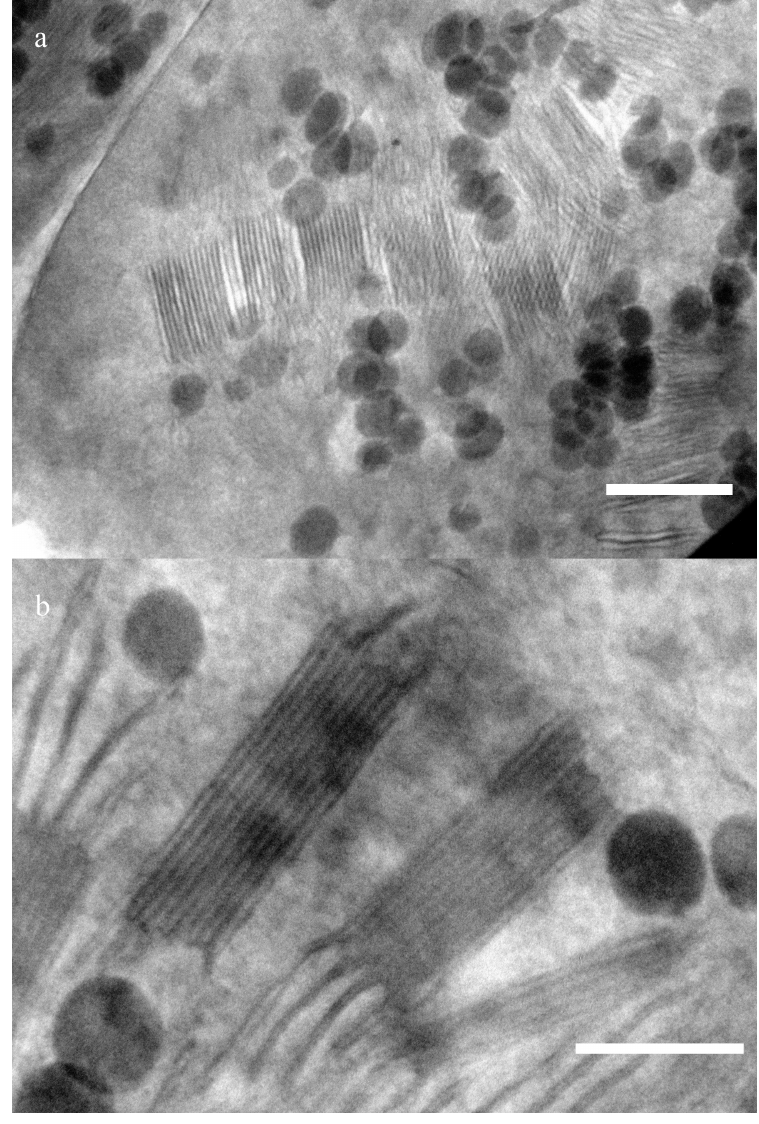
Figure 1. Transmission electron microscopy images of chloroplast in wheat samples: ( a ) 500 nm scale. ( b ) 200 nm